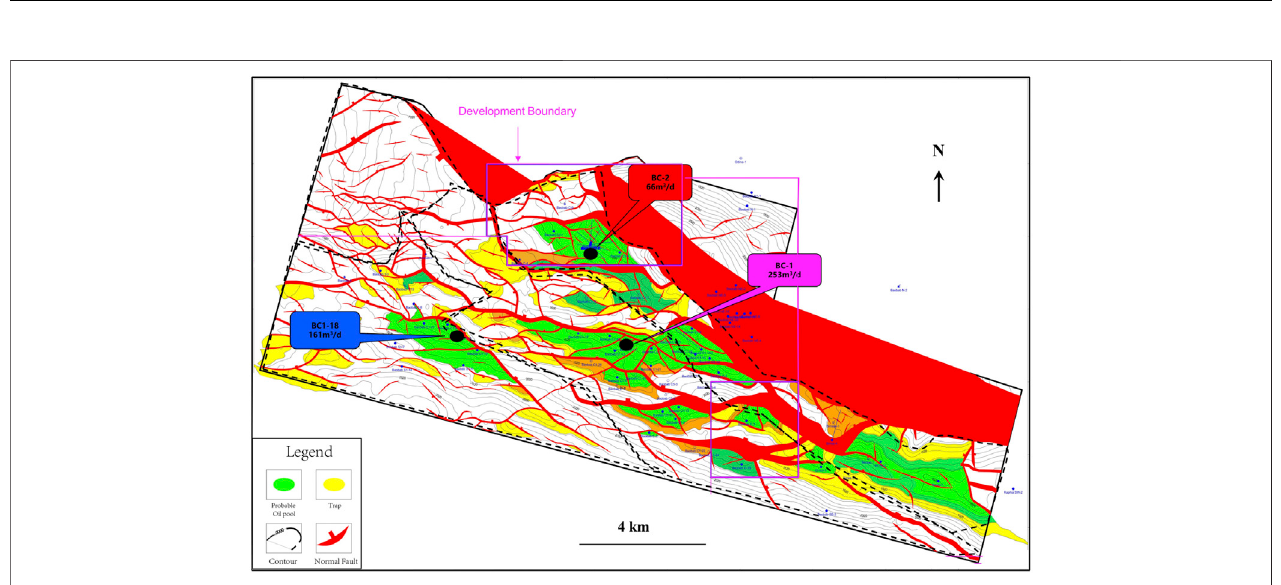
FIGURE 11 | Structural diagram of the top of the buried hill in the BC block (green indicates oil-bearing areas and yellow indicates traps).